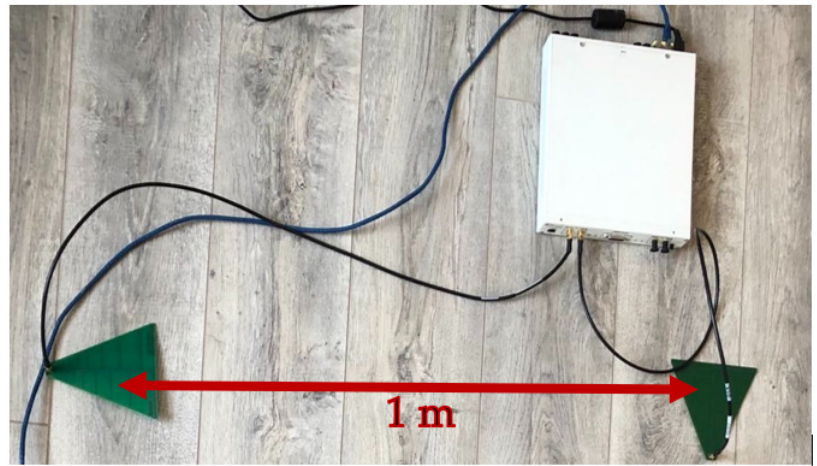
Figure 3. Experimental setup for FD transceiver testing.